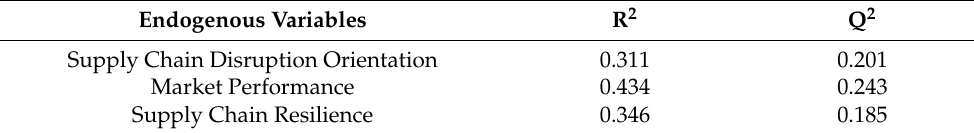
Table 6. Structural Model Assessment.